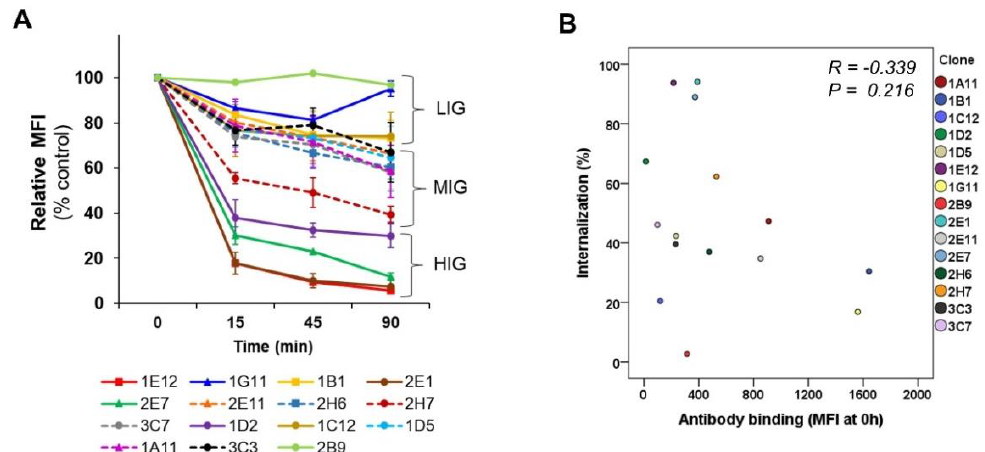
Figure 3. Comparative internalization analysis of MDA-MB-453 binding scFv-phage antibodies. ( A ) Kinetics of internalization for representative scFv-phage antibodies were analyzed at the indicated times by flow-based internalization assay. Surface remaining antibodies were detected by mouse anti-M13 phage Ab and Alexa Fluor ® 647 conjugated secondary Ab. The antibodies were categorized as high internalization group (HIG), medium internalization group (MIG) and limited internalization group (LIG) based on the rates and levels of internalization according to cut-off described in the text. The results represent mean ± SEM from at least four independent experiments. ( B ) Analysis of Pearson’s correlation between scFv-phage Ab internalization (1.5 h at 37 °C), and MFI of Ab binding to MDA-MB-453 before Abs are allowed for endocytosis, which sets the 100% mark for each Ab (0 h). Calculated correlation coefficient and p- value are also included.